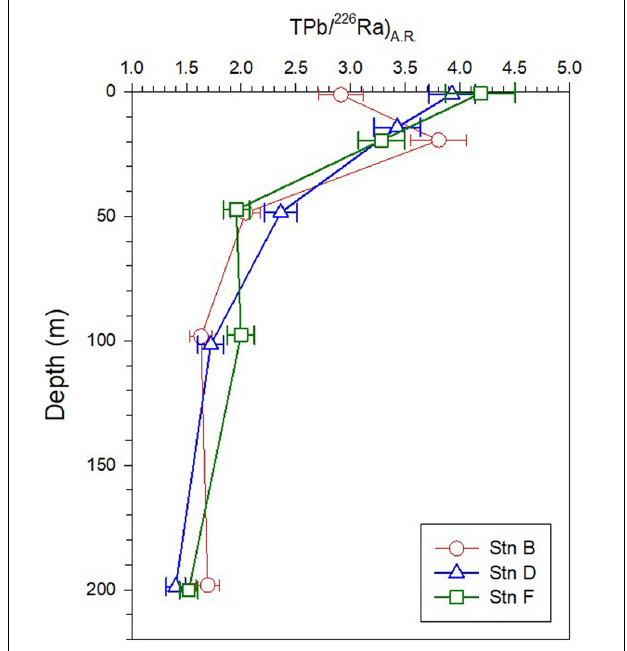
FIGURE 6 | Profiles of (TPb/ 226 Ra) A . R . in the upper 200 m at the three sites.